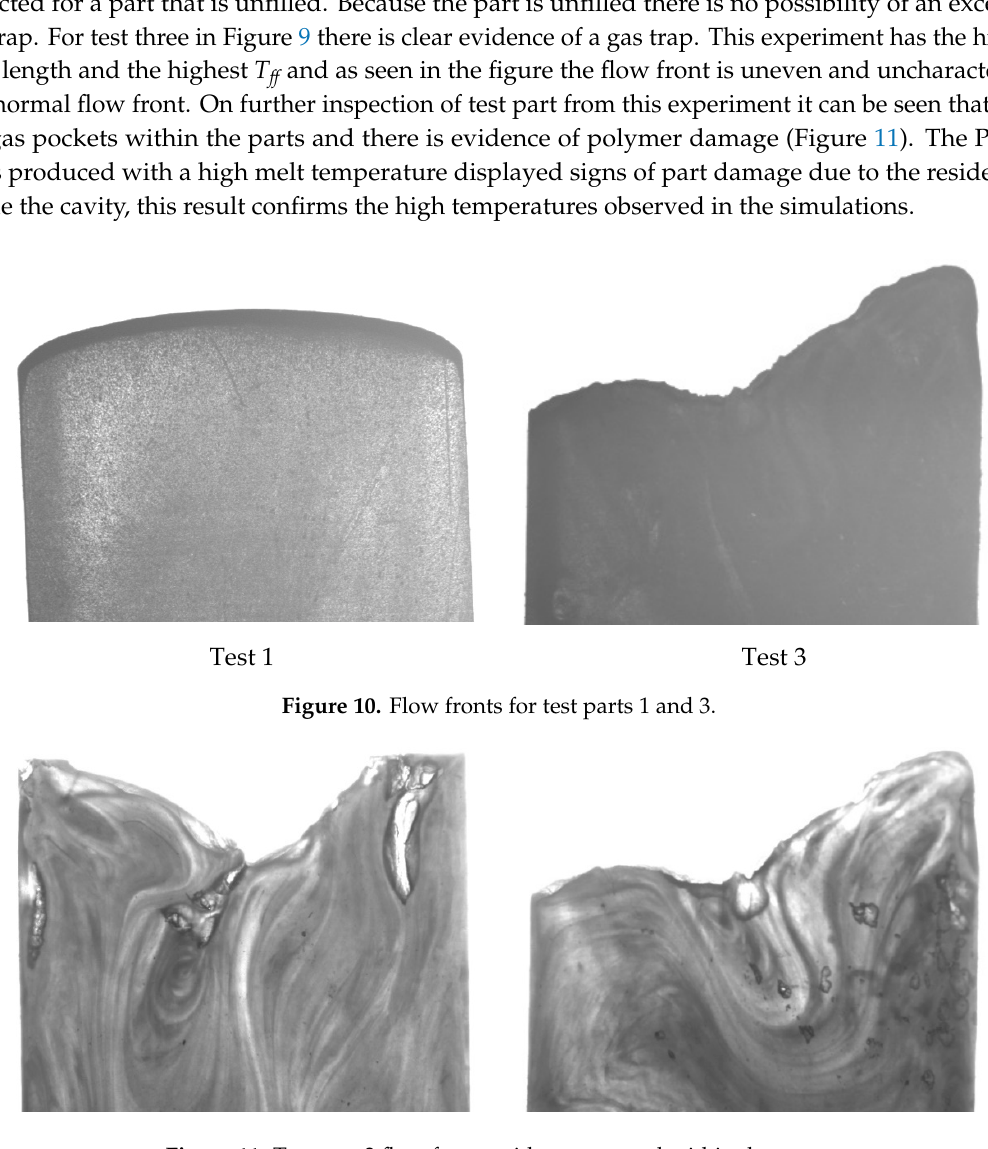
Figure 9. PP flow lengths for physical Tests 1-9.